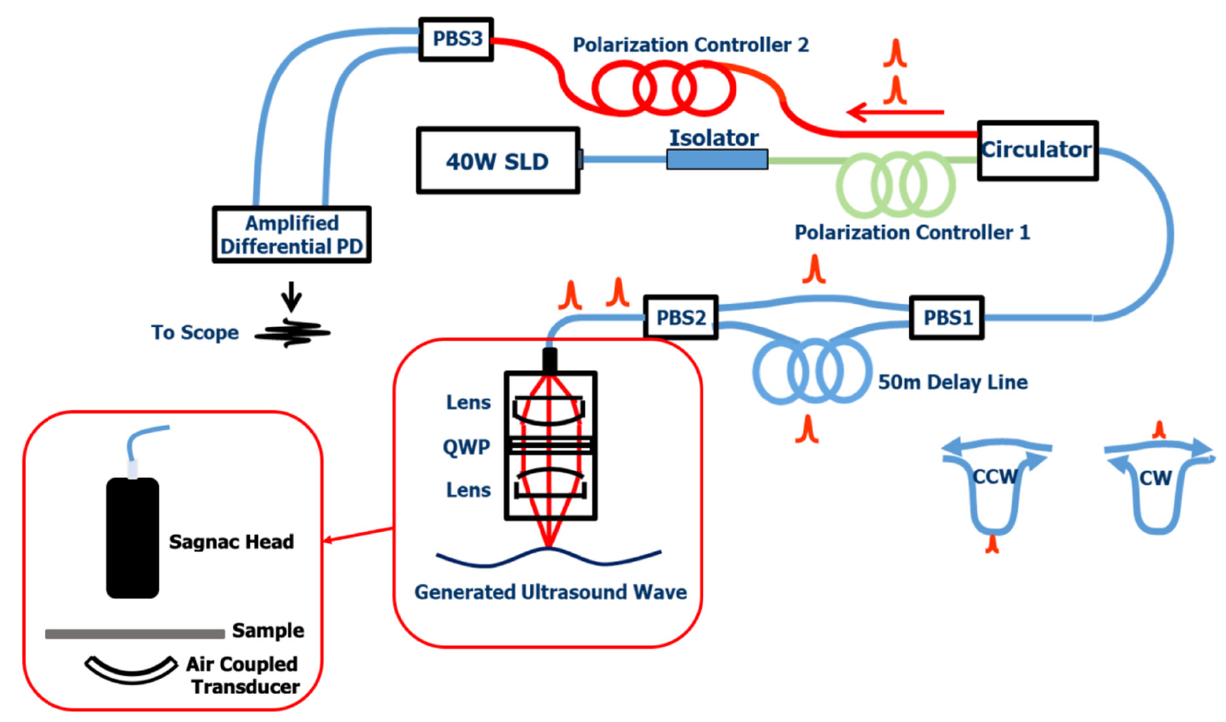
Figure 6. The Sagnac system principle diagram